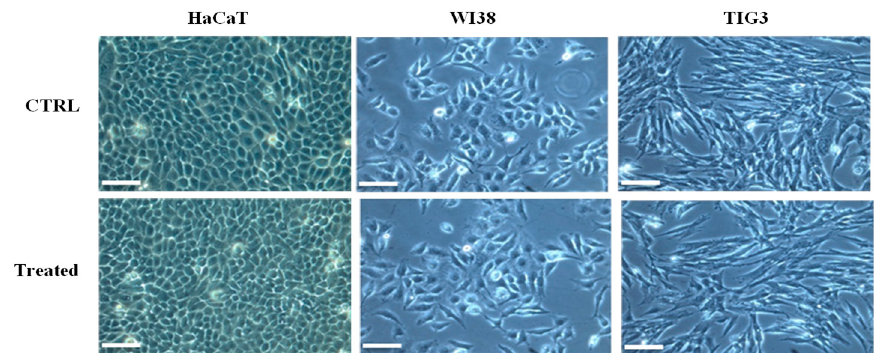
Figure 8. Morphological observation of di ff erent human cell lines treated with RiLK1 under phase-contrast microscope. Keratinocyte (HaCAT), embryonic (WI38), and fetal (TIG3) lung fibroblastic cell lines were incubated at 37 ◦ C for 24 h in absence (CTRL) or in presence (treated) of RiLK1 at the maximum concentration tested (10 µ M). The microscope images are representative of three independent experiments performed in triplicate. Bar is equal 100 µ m.